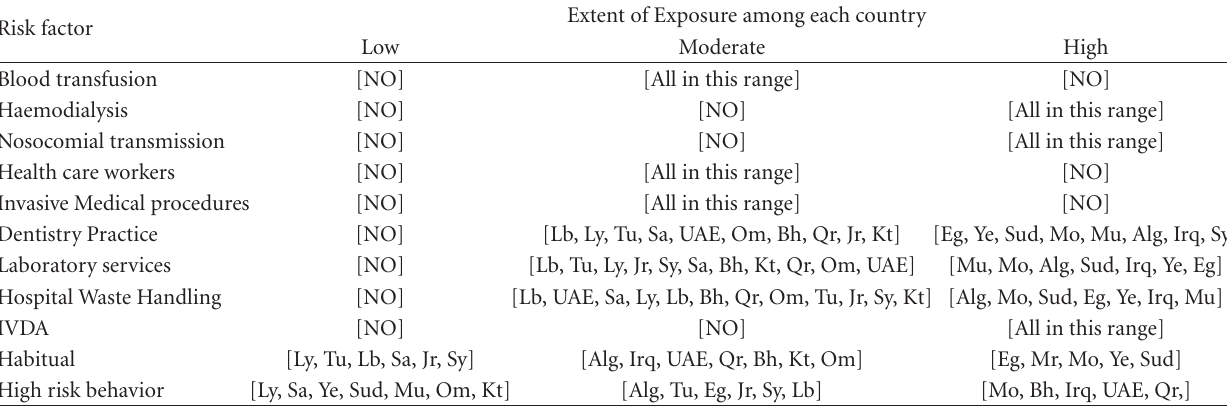
Table 3: Factors associated with the Transmission of HCV among Arab